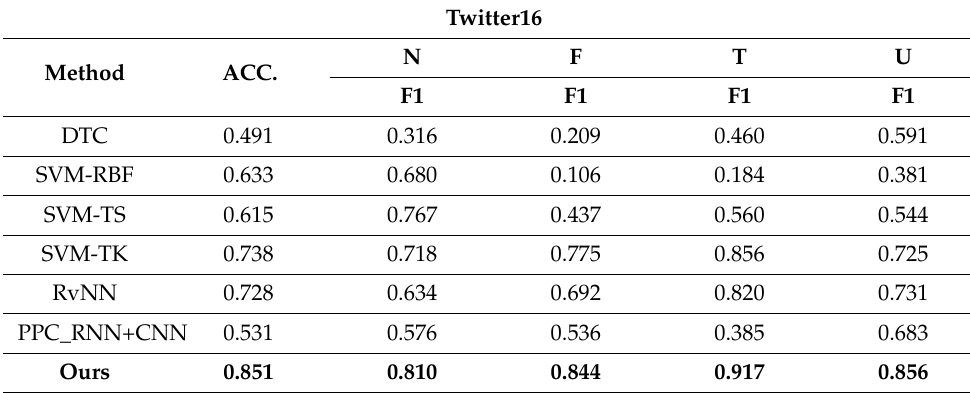
Table 5. Rumor detection results on